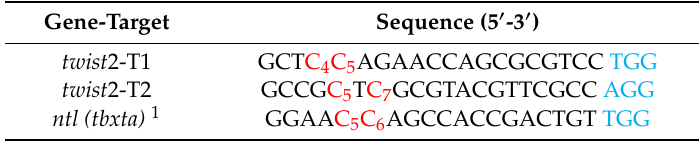
Table 1. Sequence of sgRNA targets with target Cs marked in red and PAM sites in